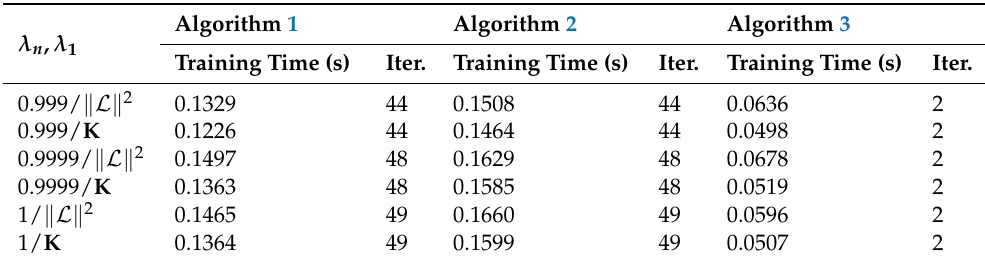
Table 2. Numerical results of different parameters λ n , λ 1 .